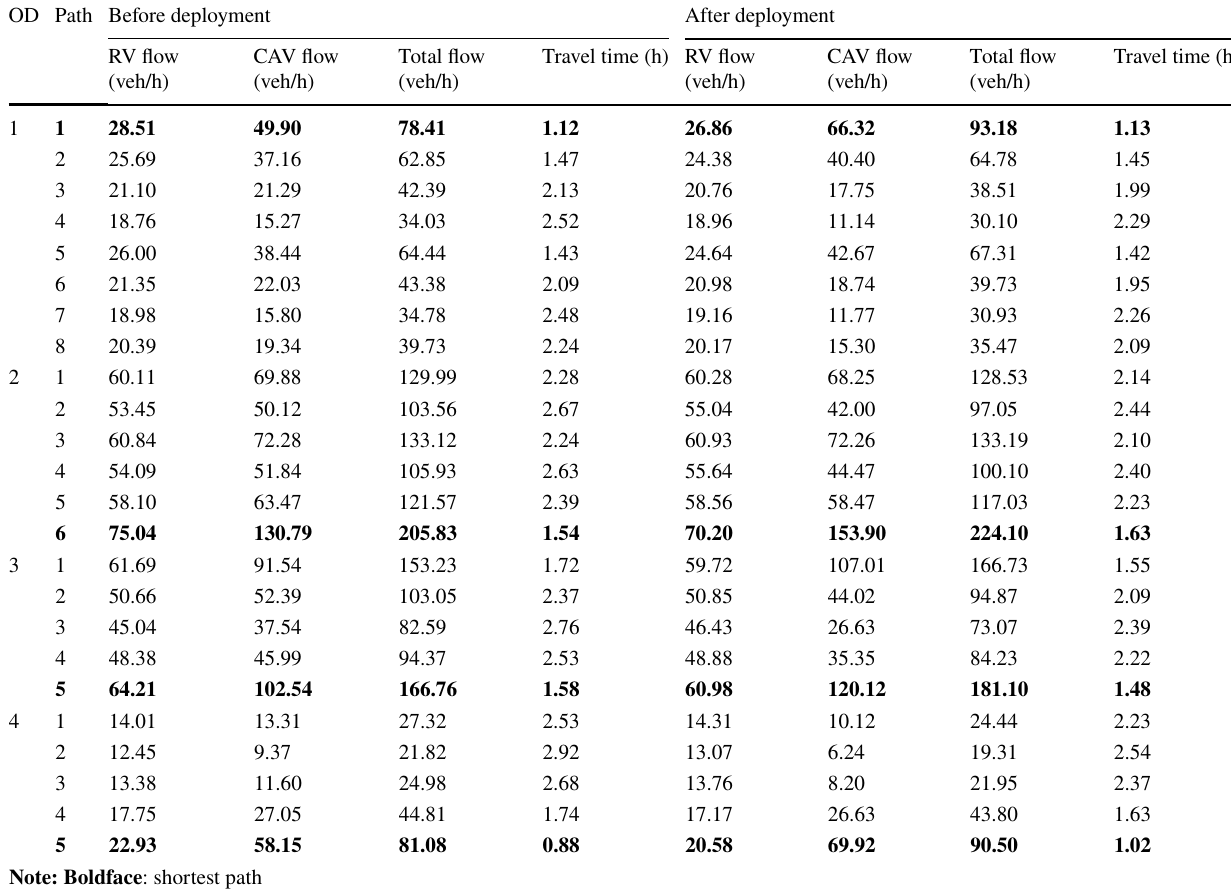
Table 6 Path flow and travel time before and after the deployment OD Path Before deployment After deployment RV flow CAV flow (veh/h) (veh/h)